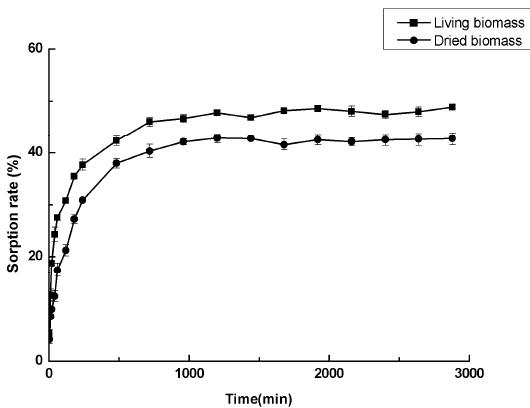
Figure 11. The equilibrium sorption curve of both biomass sorption patterns. ( p = 0.000). Table 3. The sorption ability of P. shigelloides H5 compared to E. coli DH5 α .